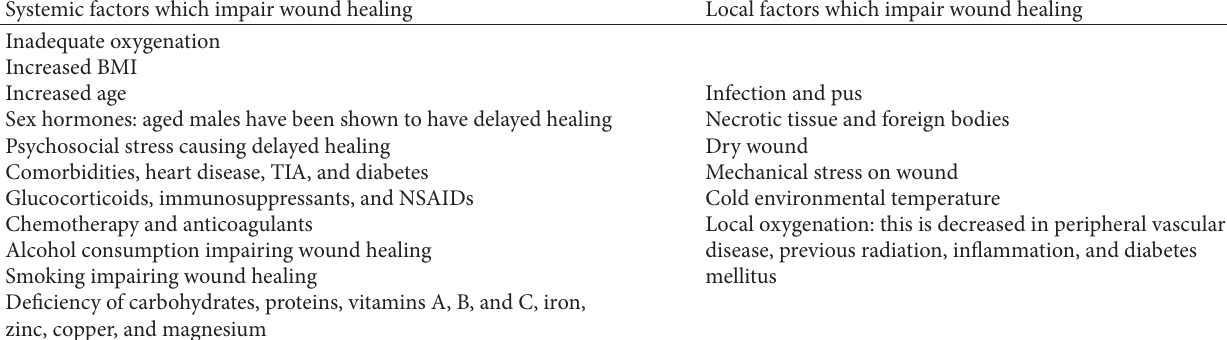
Table 6: Some of the factors that affect wound healing